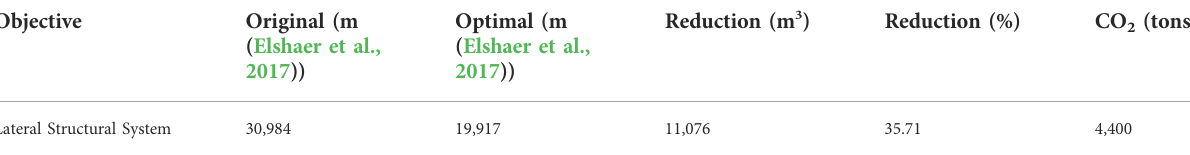
TABLE 3 Structural optimization